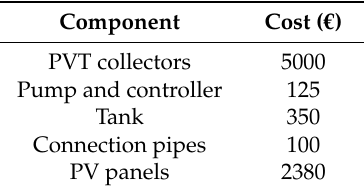
Table 2. Costs of the components.